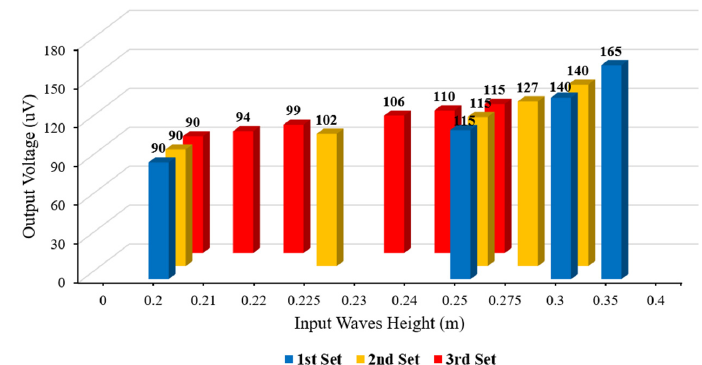
Figure 14. Resolution testing of the sensor based on the proposed dynamic model.